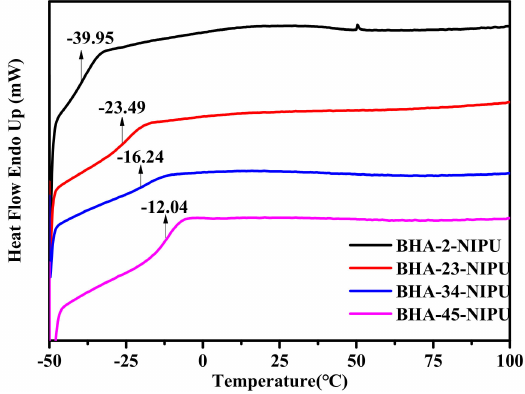
Figure 6. Di ff erential scanning calorimetry (DSC) curves of four